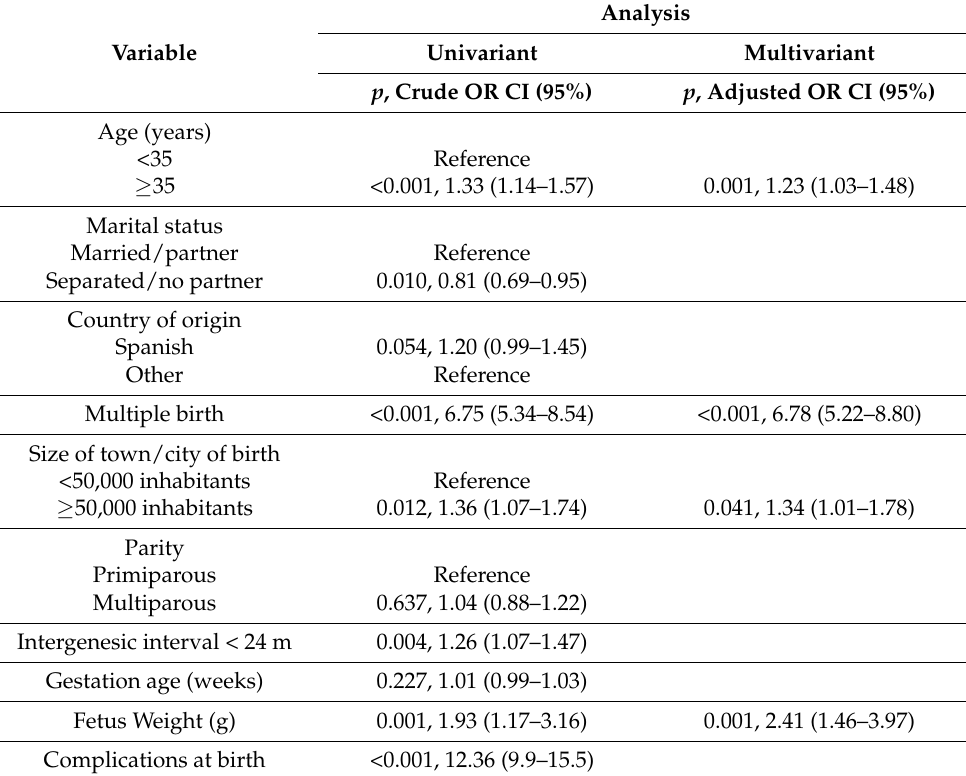
Table 3. Factors associated with cesarean birth in stillbirths of over 28